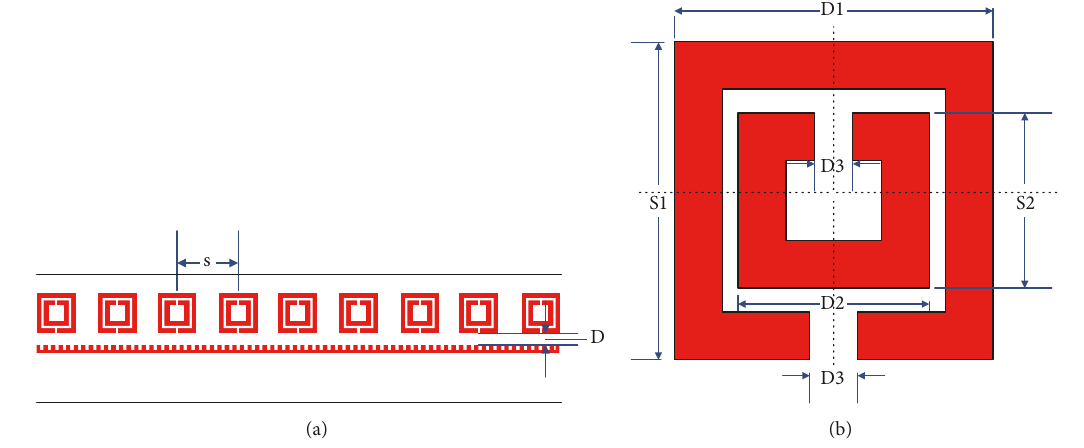
Figure 4: Layout of loading CSRR resonant structure. (a) Distribution of linear array. (b) Layout of CSRR.